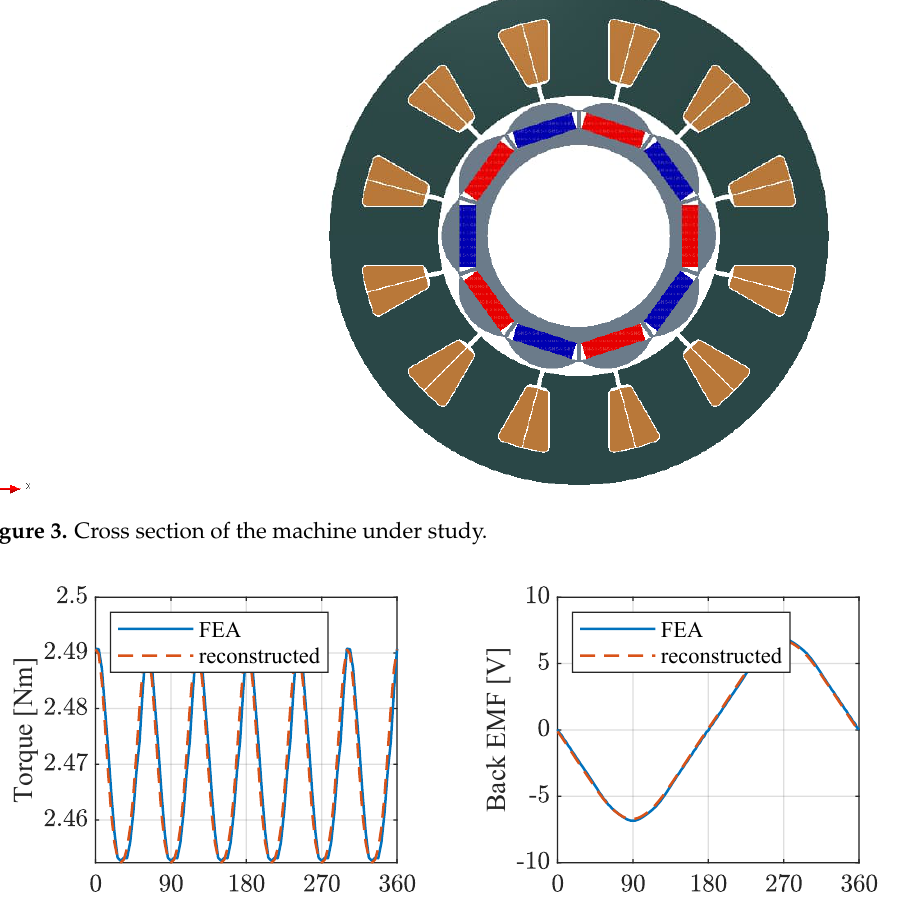
Rotor position elec.[deg.] Figure 4. Electromagnetic torque and the back emf waveforms extracted from an electromagnetic analysis (blue line) for JT = 4.39935 mm, TWS = 6.9565 mm, SO = 1.8815 mm, SOAng = 116.65 deg., TGD = 0.98125 mm and their reconstructed waveforms from the most important harmonics (red